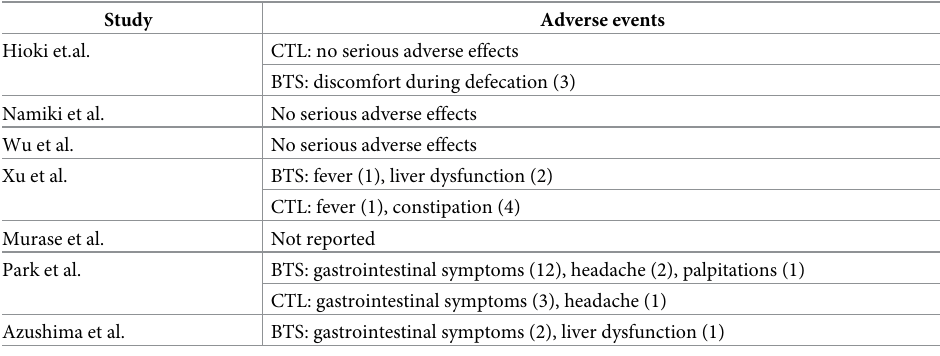
Table 4. Adverse events in the included